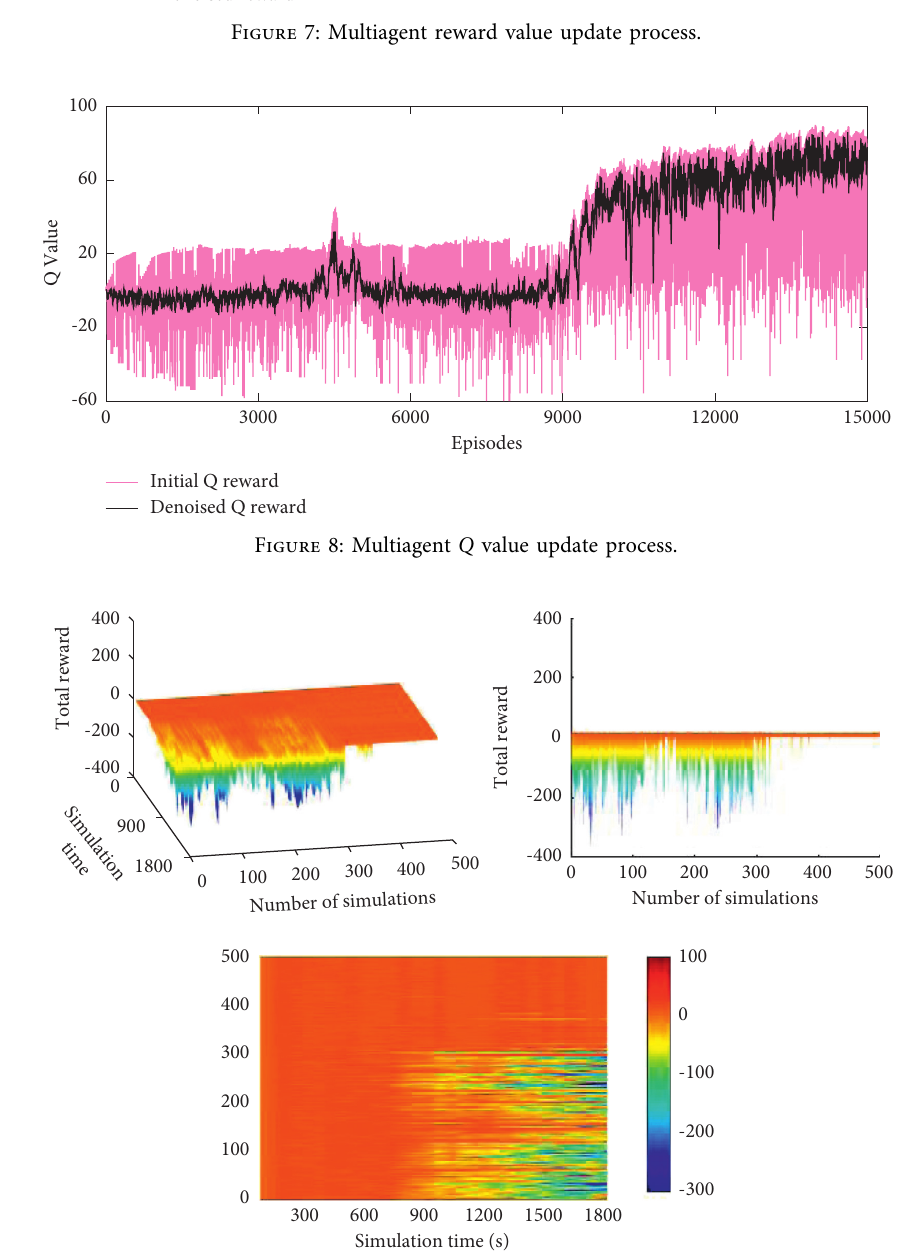
Figure 9: Three-dimensional visualization of the multiagent reward